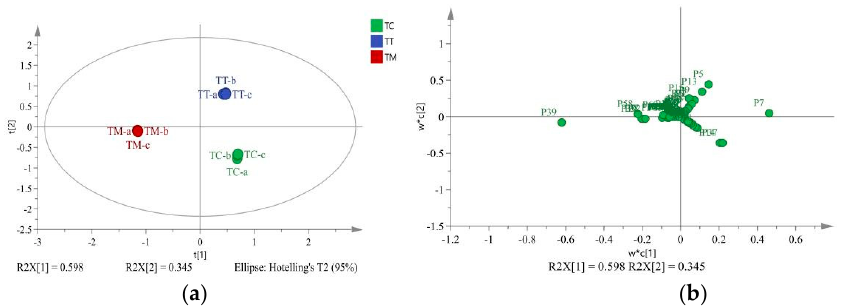
Figure 3. PLS-DA model for aroma components at different stages of the three species. ( a ) Score scatter plot; ( b ) Loading scatter